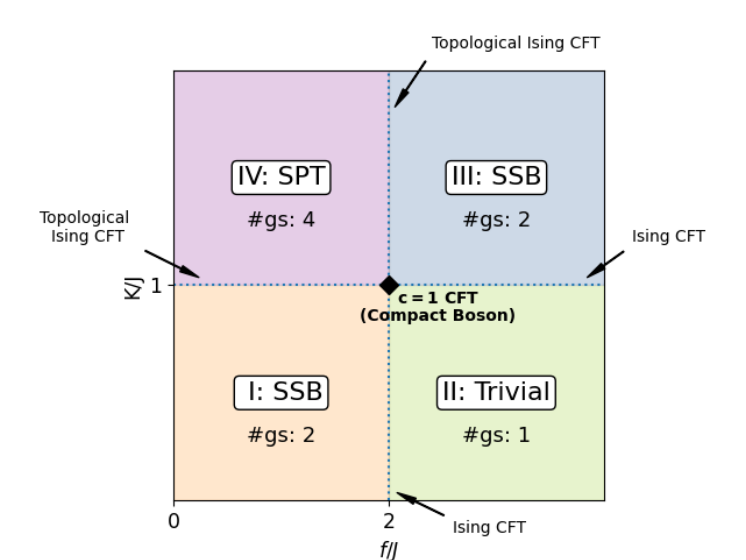
Figure 8: Quantum phase diagram of the gently gauged TFIM (69) at h = 0. The Ising transition lines are straight, as a consequence of the exact dualities. The intersection point (diamond) corresponds to a CFT with central charge c =